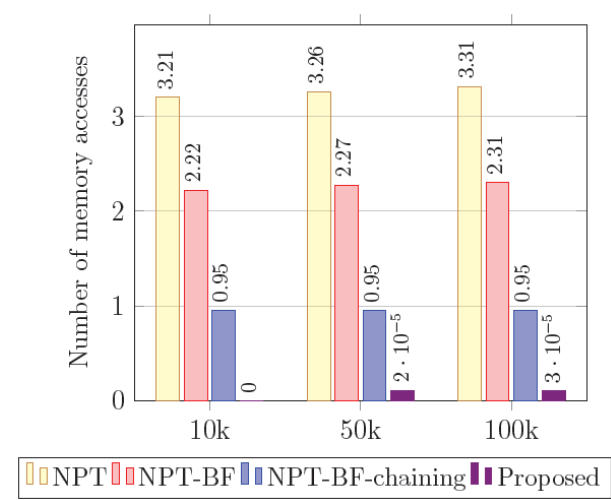
Figure 4. Average number of off-chip memory